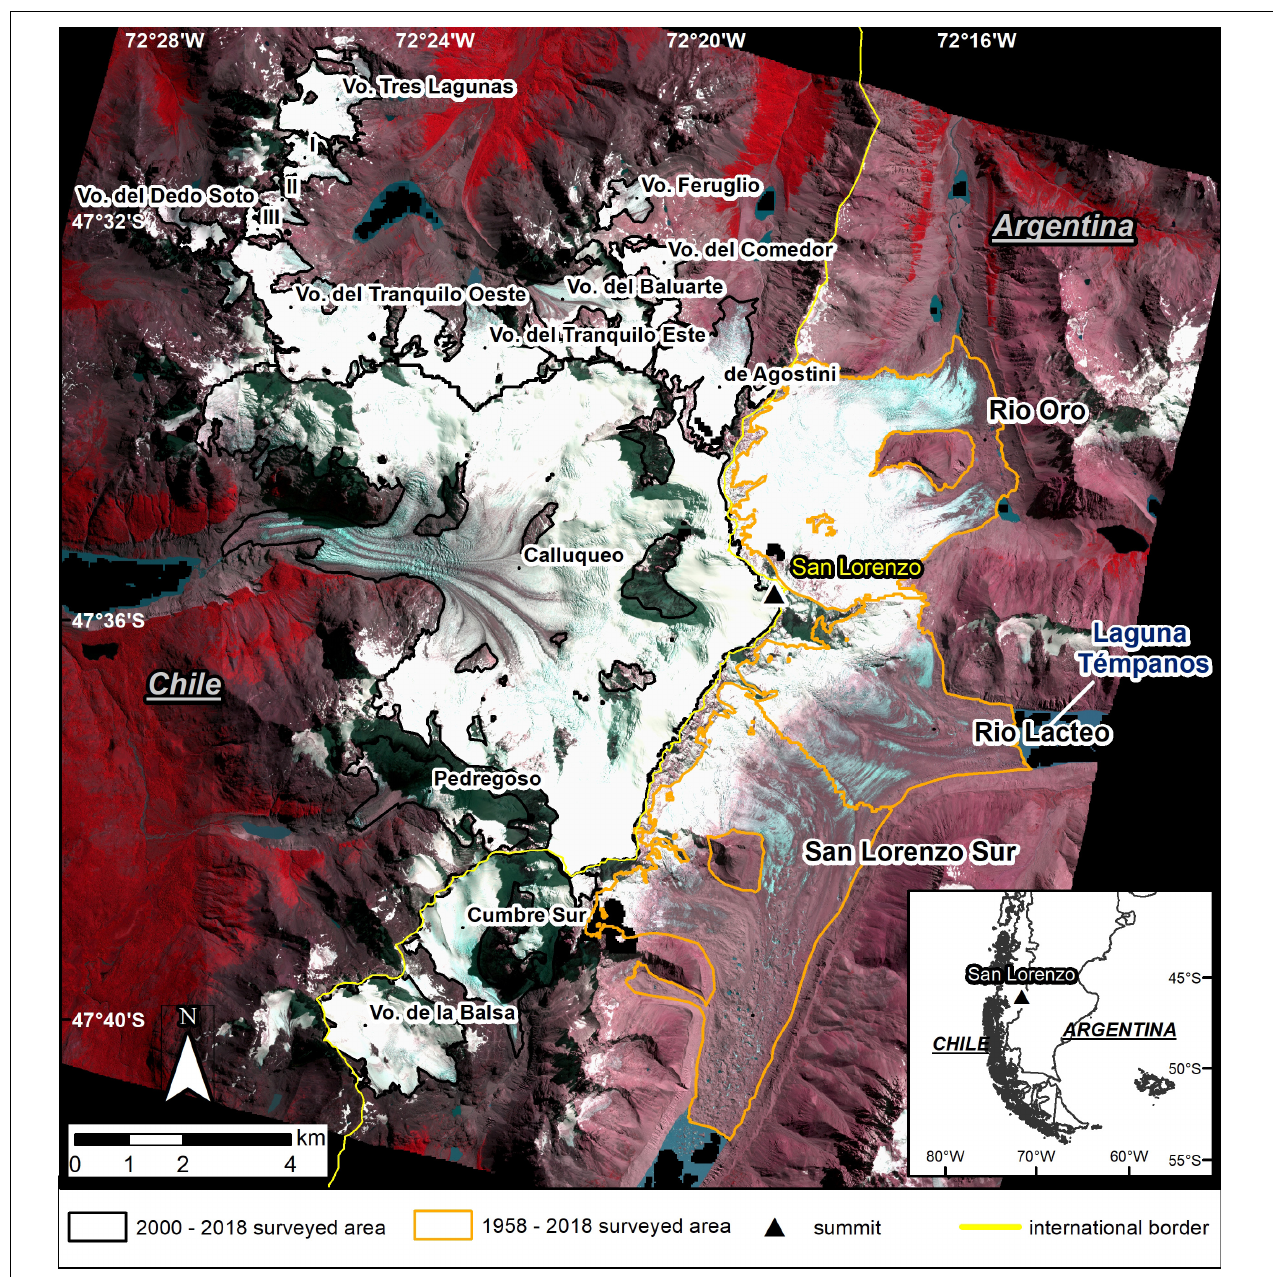
FIGURE 1 | Overview of the Monte San Lorenzo area and the investigated glaciers. I, II and II stand for three unnamed glaciers in the Tres Lagunas basin. Background image is a Pleiades RGB 432 composition. Vo, Ventisquero (lower part of a glacier in